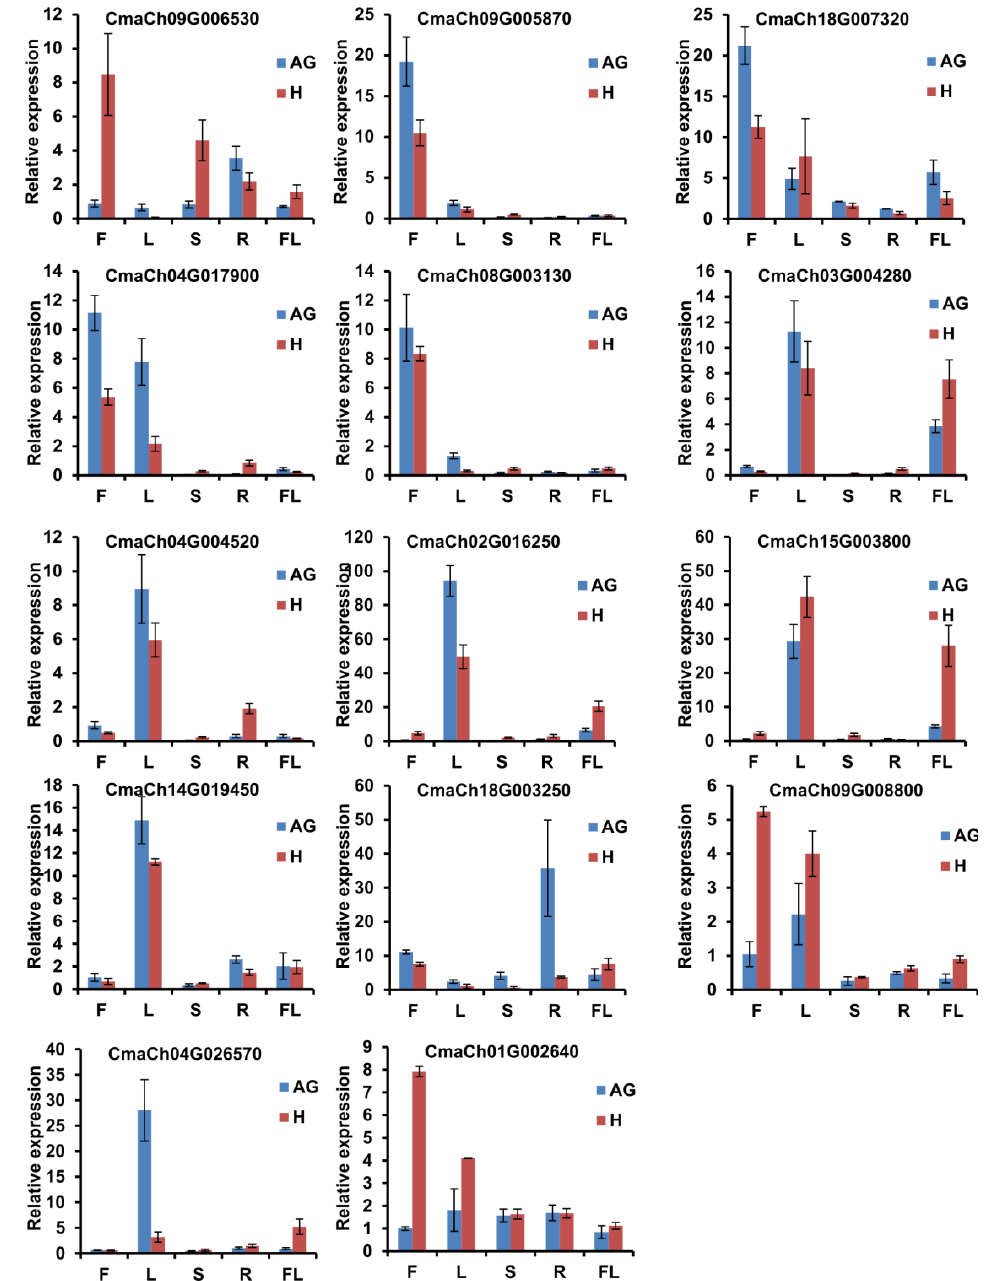
Figure 6. Expression analysis of CmWD40 genes in different tissues of Atlantic Giant (AG) and Hubbard (H). F (Fruit at 30 days after flowering), L (Mature leaves), S (Stems near the fruit), and FL (Flower buds) were used to characterize. The gene expression levels are normalized to the internal control of CmEF. The error bars represent the standard deviation of three biological replicates.